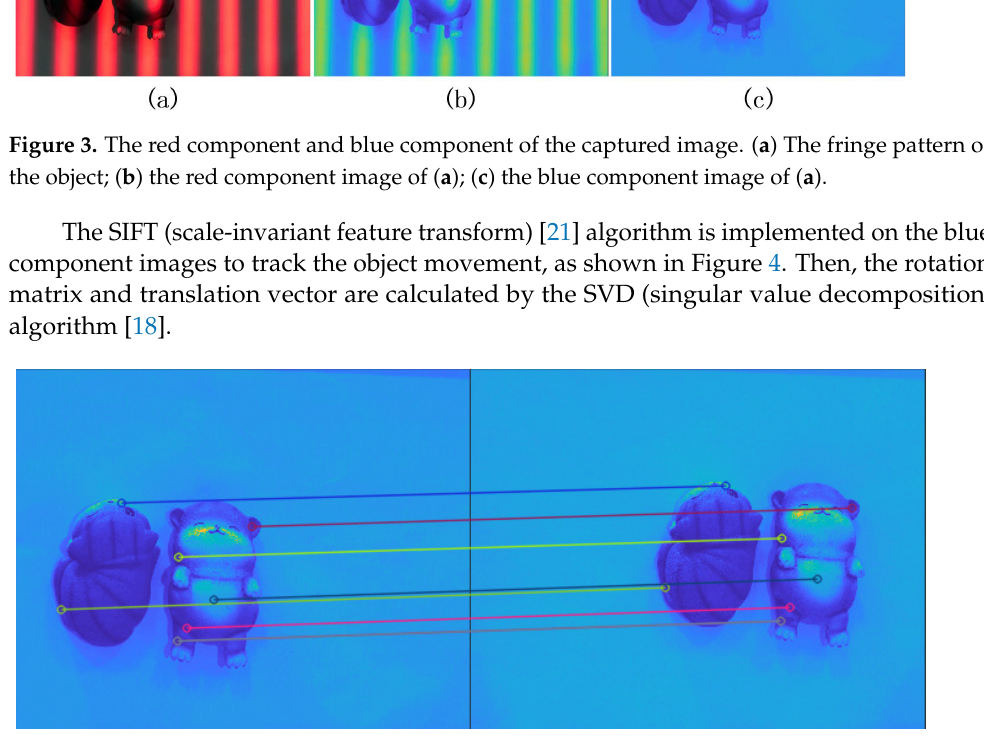
Figure 4. The result of the SIFT algorithm.